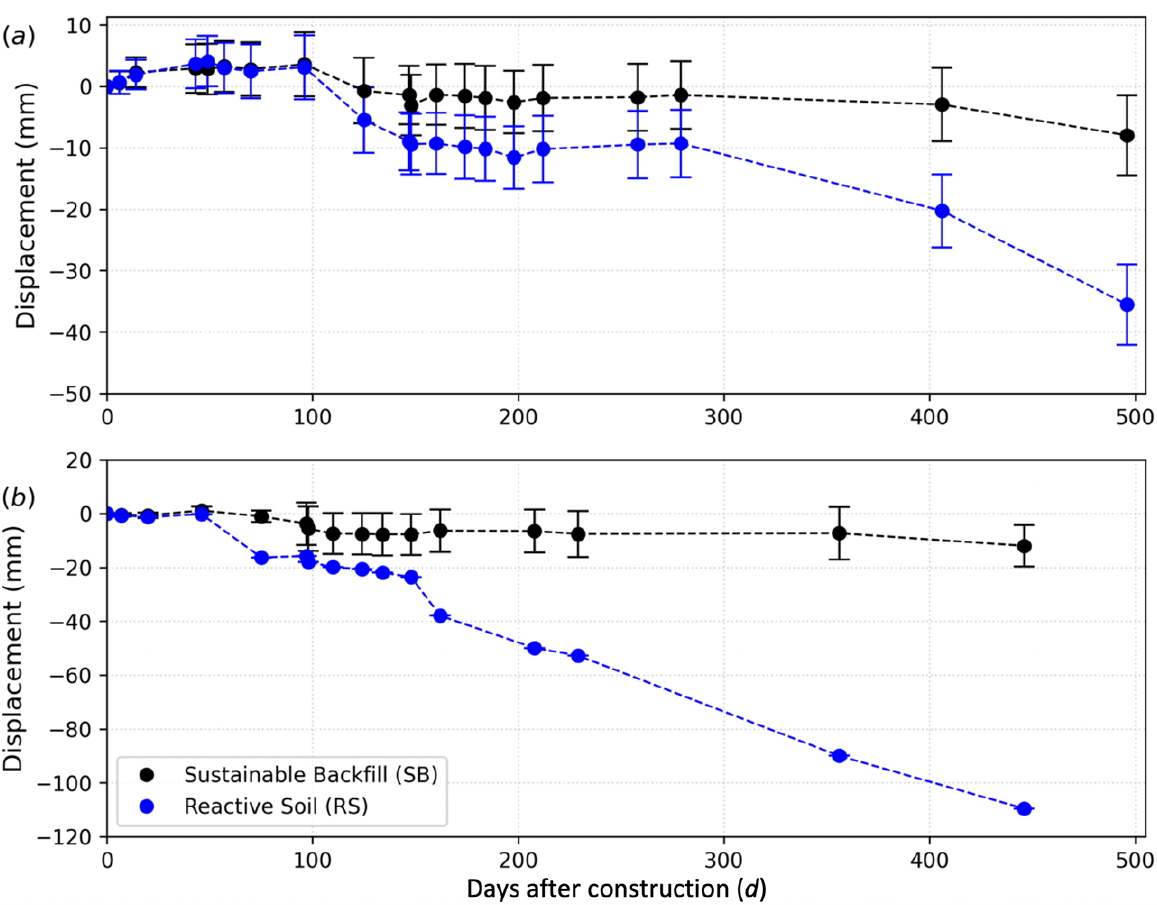
Figure 7. Mean cumulative soil movement in ( a ) Area 1 and ( b ) Area 2. Error bars are showing the standard deviation of the measurements of each date.